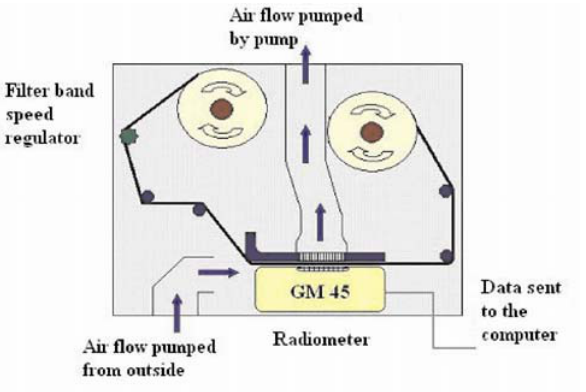
Fig 2. Measurement control equipment